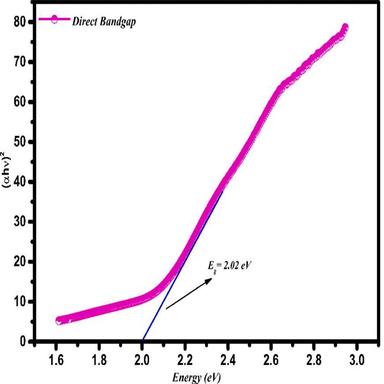
Tau plot of the sample La2SrFe2TiO9 for the determination of the energy bandgap.